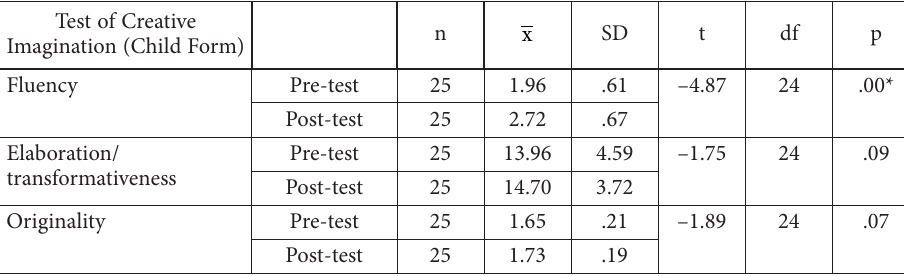
Table 1. Paired Samples T-Test results of children in the experimental group concerning their pre- test-posttest mean scores (source: created by author) Test of Creative Imagination (Child Form)